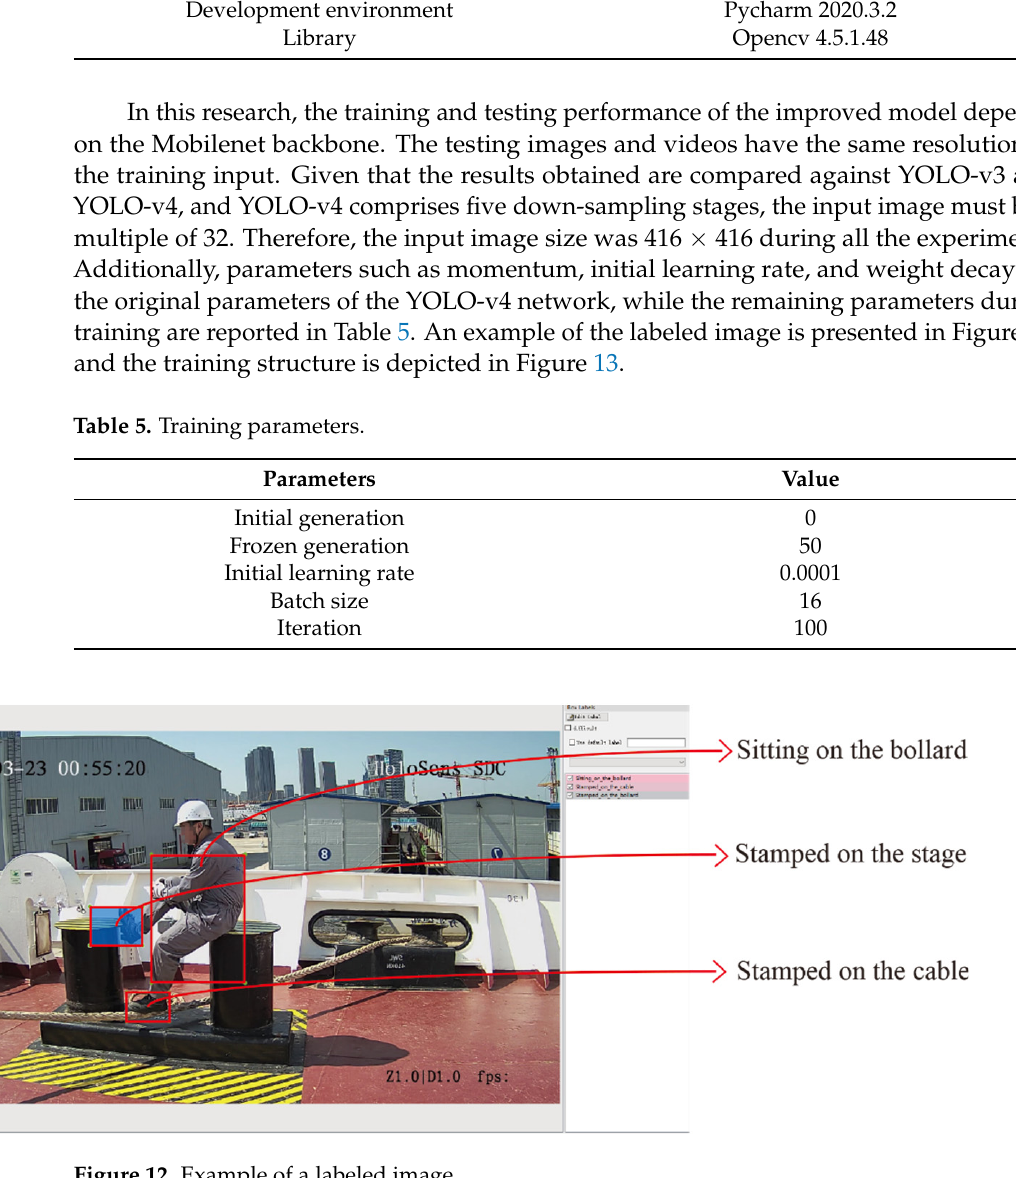
Figure 12. Example of a labeled image.